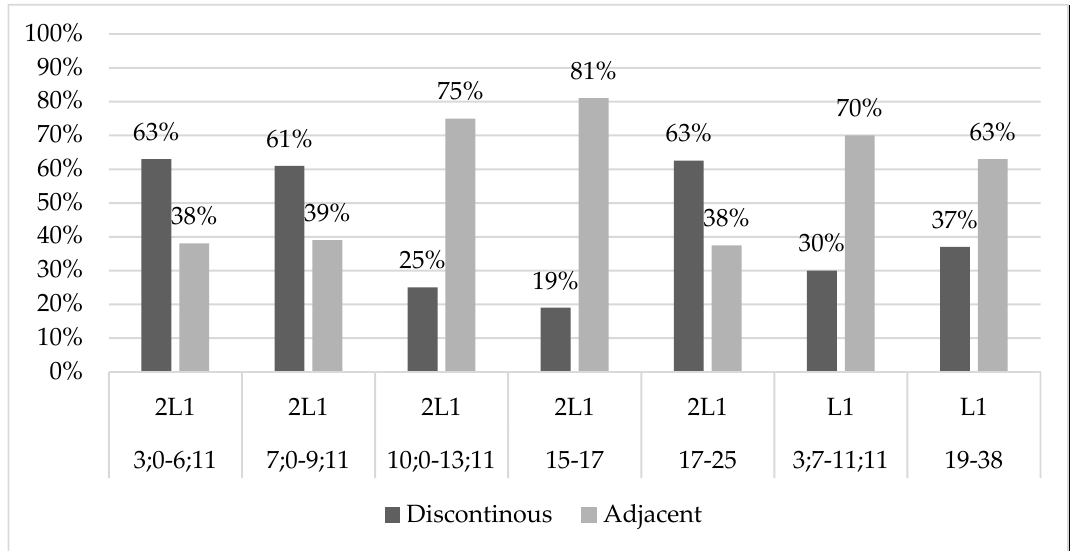
Figure 1. Relative frequency of discontinuous vs. adjacent word order pattern in simultaneous bilinguals (2L1) and monolinguals (L1).